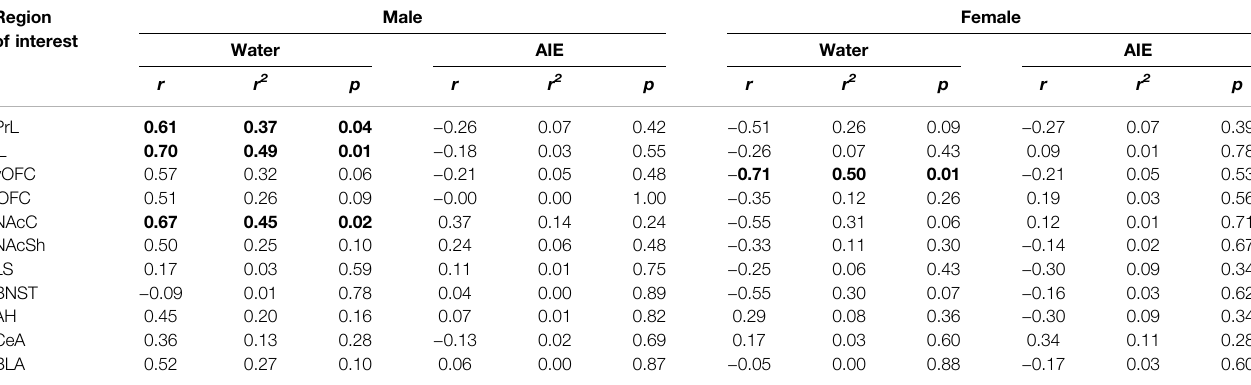
TABLE 3 | The relationship between social investigation and the number of β -gal positive cells for each region of interest of water and AIE exposed males and females assessed with Pearson correlation and linear regression analyses. Region of interest